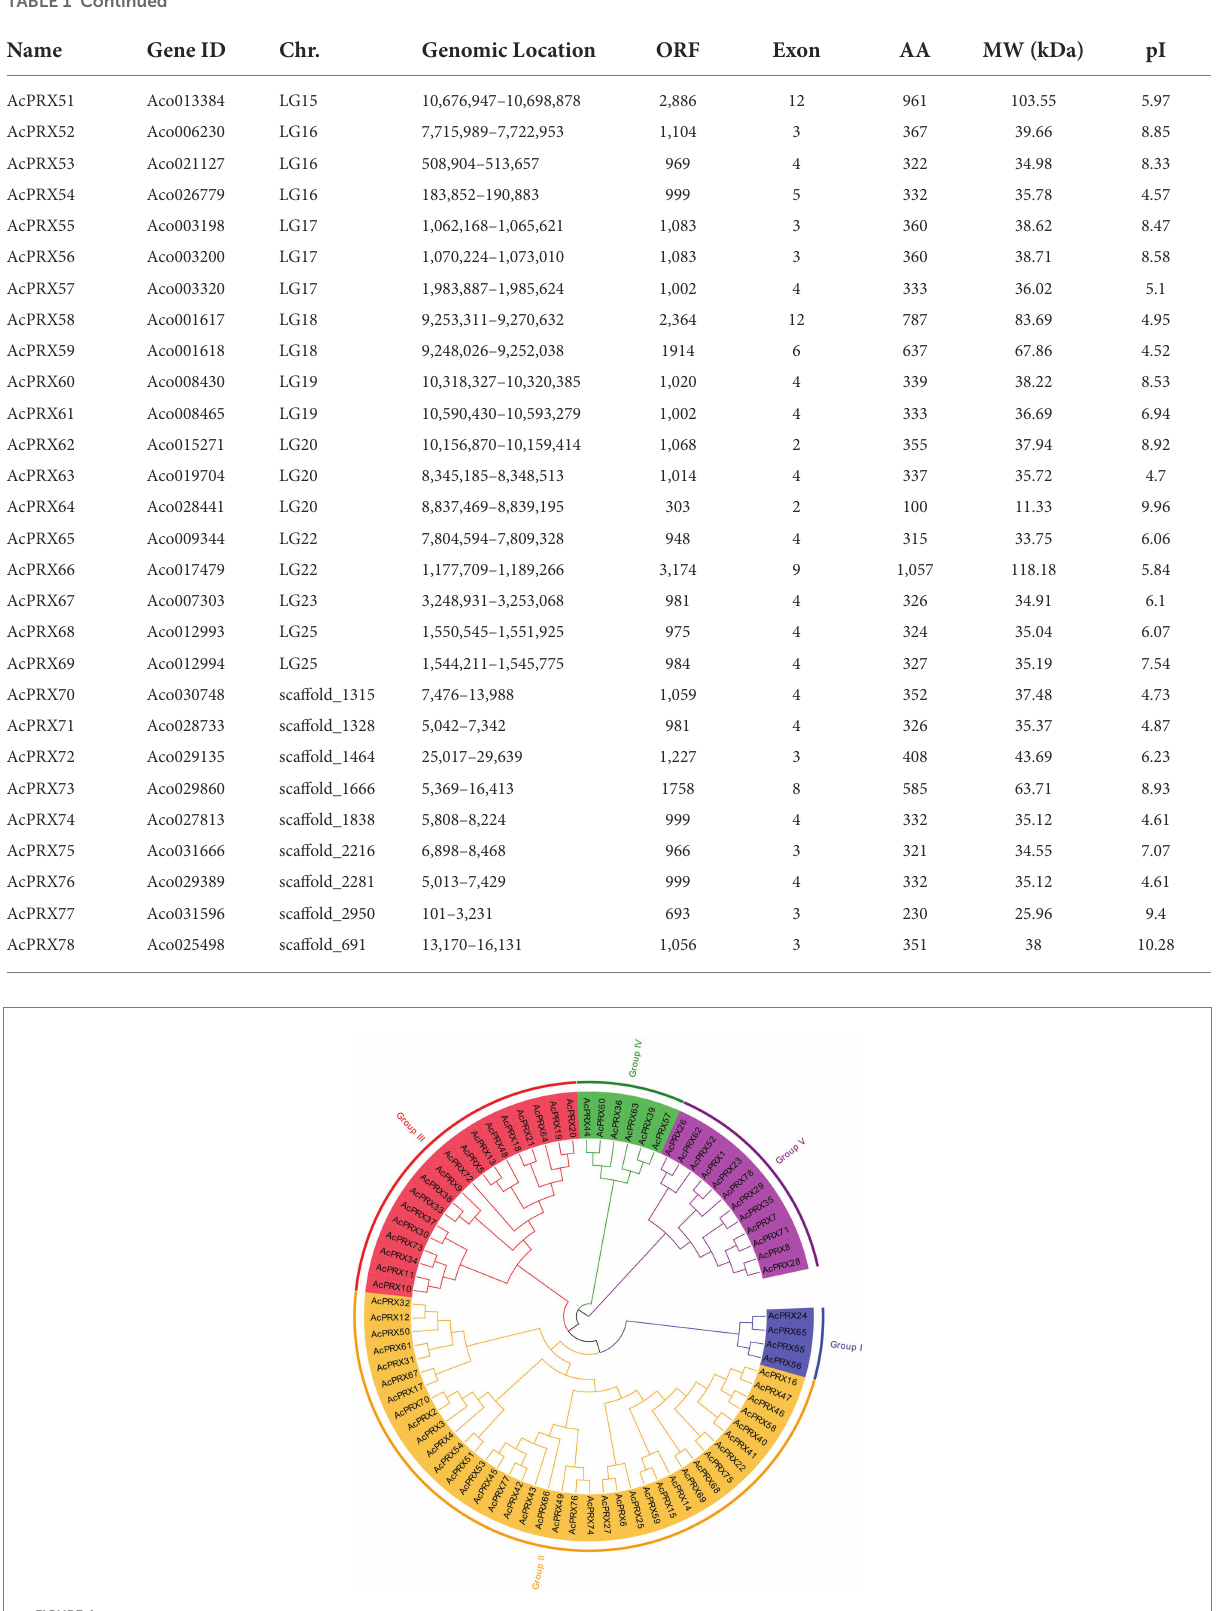
FIGURE 4 Classification and phylogenetic analysis of pineapple PRX genes. There were a total of 78 PRXs , all of which were used to construct the phylogenetic tree with the neighbour-joining (NJ) method and 1,000